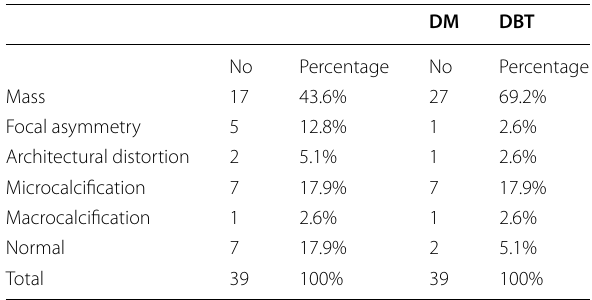
Table 1 Distribution of all lesions according to their BIRADS Table 2 Comparison between DM and addition of DBT